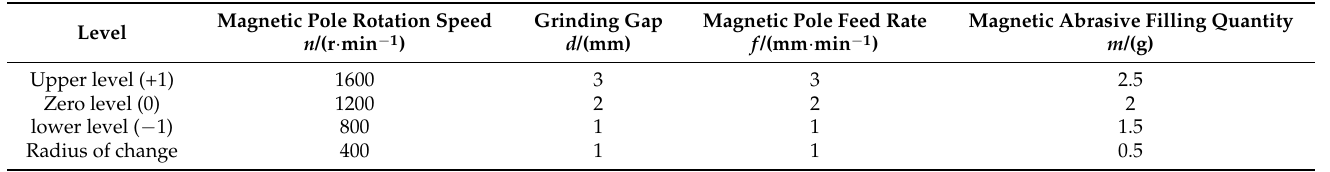
Table 3. Correspondence table of factor